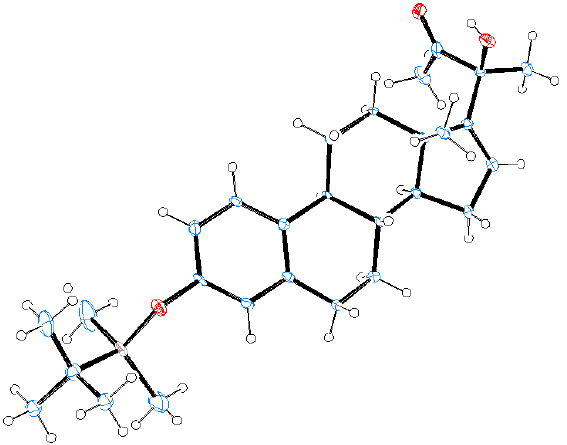
Figure 2. X-ray crystal structure of 11a showing the R -configuration around C-19 [31]. As illustrated in Scheme 2, the precursor 2-(( tert -butyldimethylsilyl)oxy)-2- with the key intermediates α -hydroxymethylketones 11a , b using LDA to afford the de-